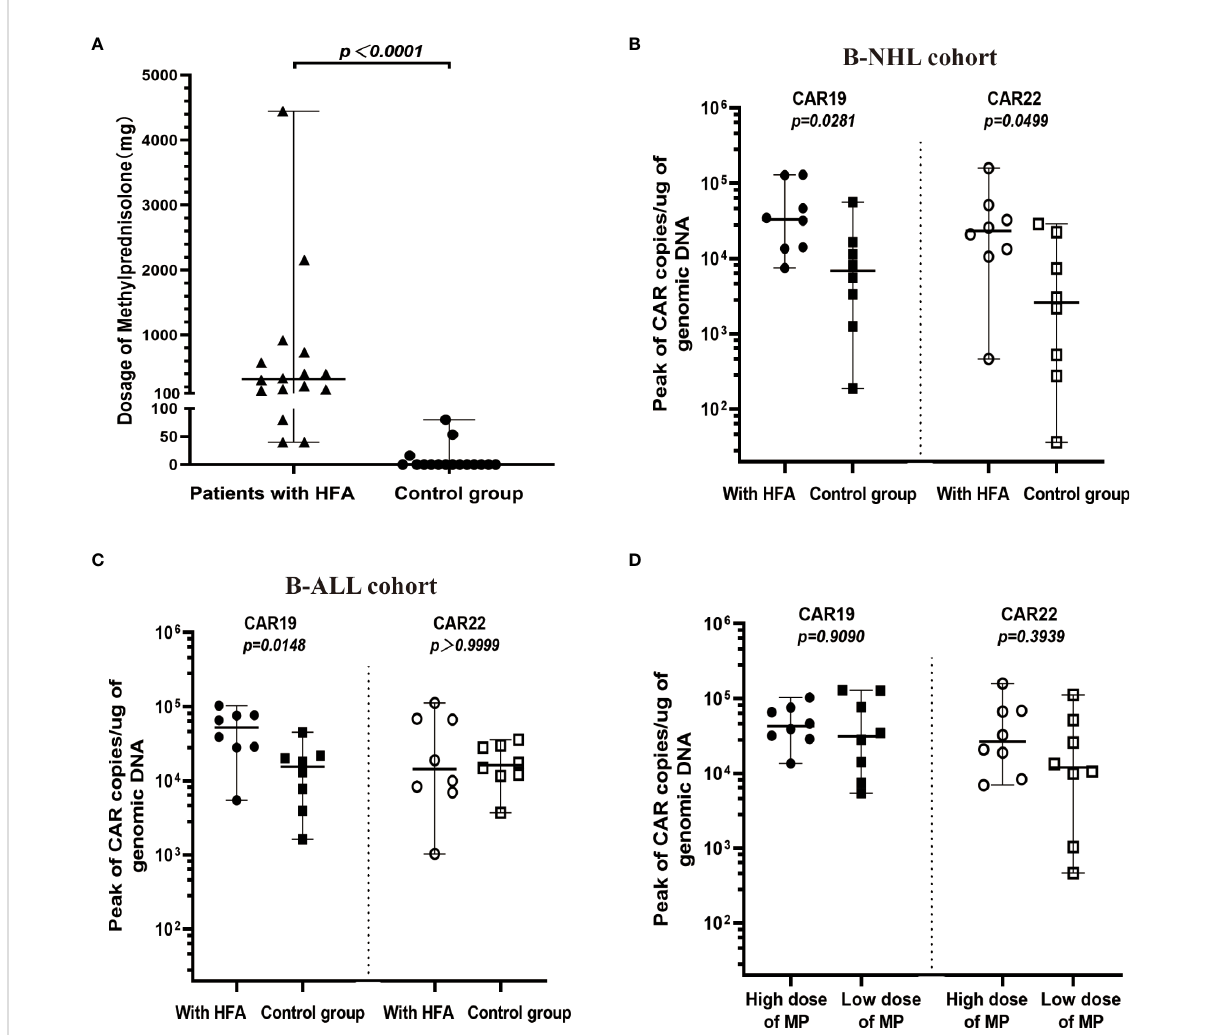
FIGURE 4 Cellular kinetics of CAR transgenes in peripheral blood. (A) Comparison between HFA group (n=16) and control group (n=16) in dosages of MP (median 320 mg, range 40-4447 mg, and median 0 mg, range 0-80 mg, respectively), only 3 patients in the control group received MP after the CAR-T cell infusion. (B) In B-NHL cohort, the peak values for CAR19 and CAR22 transgene copies in the HFA group (median 33222, range 7458- 129375 copies/µg for CAR19 and median 23284, range 464-159171 copies/µg for CAR22) were all signi fi cantly higher than those in the control group (median 6864, range 187-55774 copies/µg for CAR19 and median 2588, range 36-28740 copies/µg for CAR22). (C) In B-ALL cohort, the peak values for CAR19 (median 52291, range 5441-102707 copies/µg), but not for CAR22 (median 14433, range 1033-112033 copies/µg) transgene copies in the HFA group were signi fi cantly higher than those in the control group (median 15519, range 1615-45078 copies/µg for CAR19 and median 16170, range 3703-35729 copies/µg for CAR22). (D) According to the median dose of MP (320 mg), 16 patients with HFA were divided into a low-dose MP group and a high-dose MP group. The peaks of CAR19 and CAR22 transgene copies in the high-dose MP group (median 31679, range 5441-129375 copies/µg for CAR19 and median 11949, range 464-112033 copies/µg for CAR22) were not signi fi cantly different from those in the low-dose MP group (median 42697, range 4770-102707 copies/µg for CAR19 and median 26669, range 6970-159171 copies/µg for